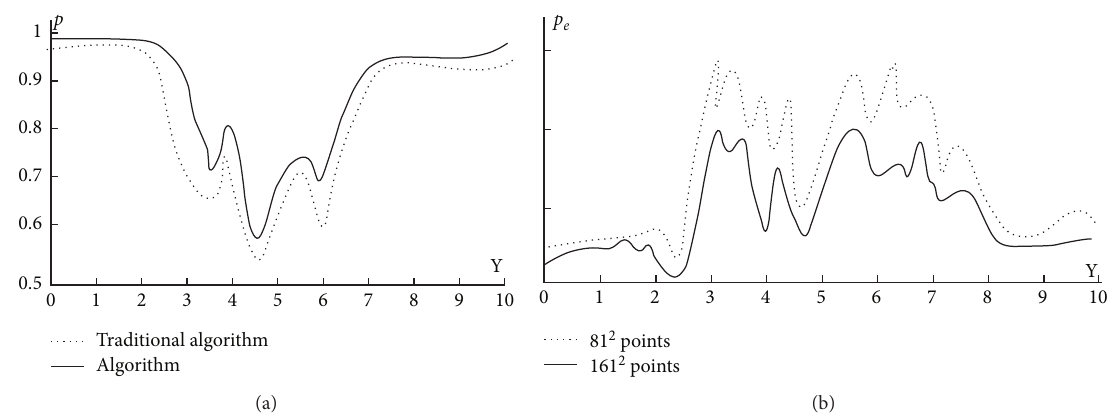
Figure 4: Two-dimensional periodic vortex problem. (a) 81 2 uniform grid, x � 5, and the solid line represents the true solution of the density. (b) The error of the density obtained by the traditional algorithm on the consistent grid of 81 2 and 161 2 , and x � 5.